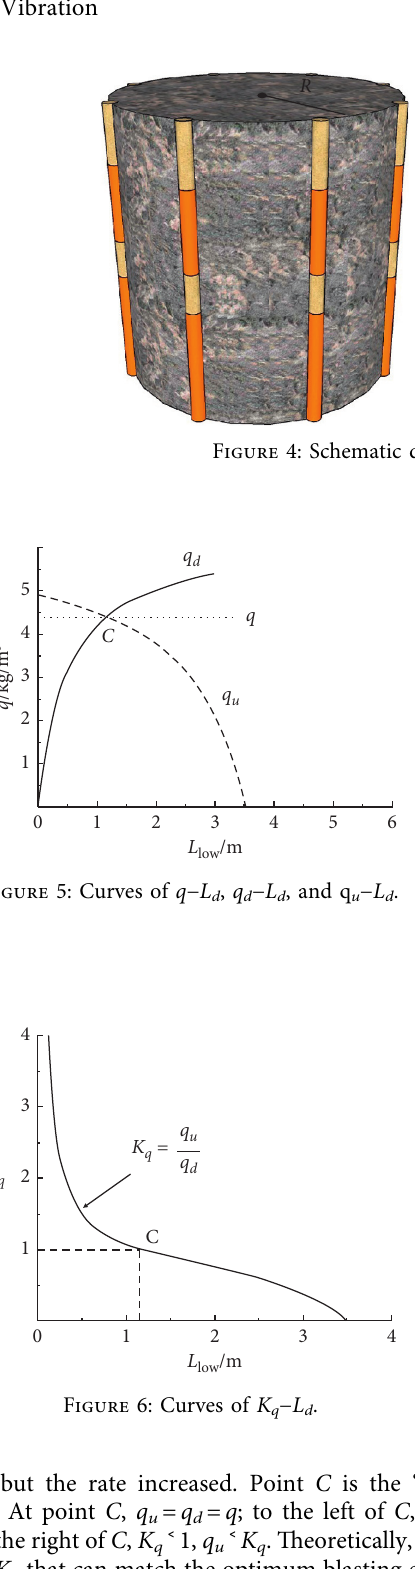
Figure 6: Curves of K